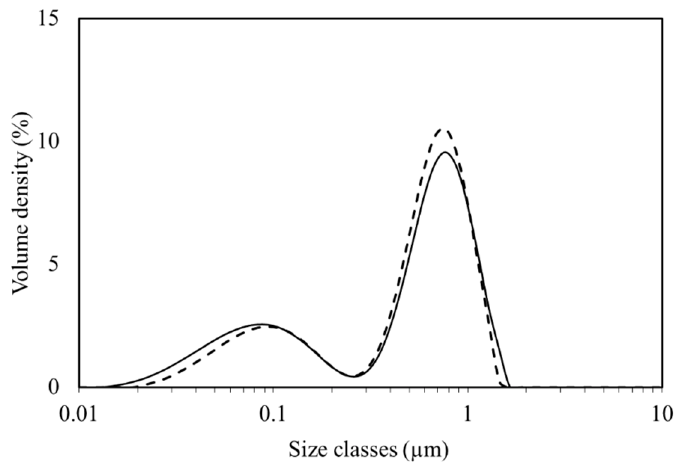
Figure 1. Particle size distribution of natural rubber (NR) in NR latex (NRL) suspension: in the absence of ethanol aqueous solution (solid line) and with the addition of ethanol solution (dash line).